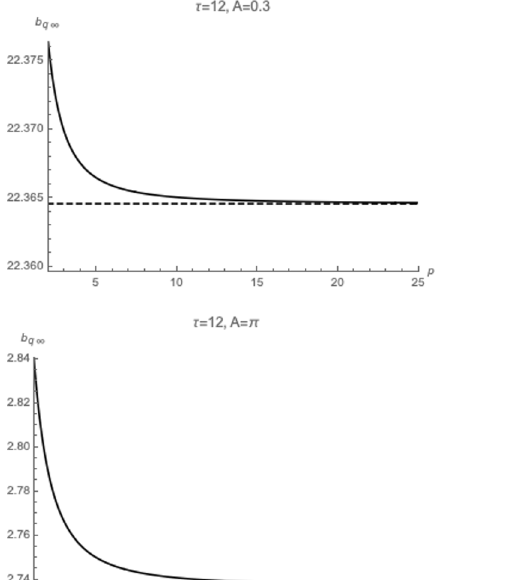
JHEP11(2020)086